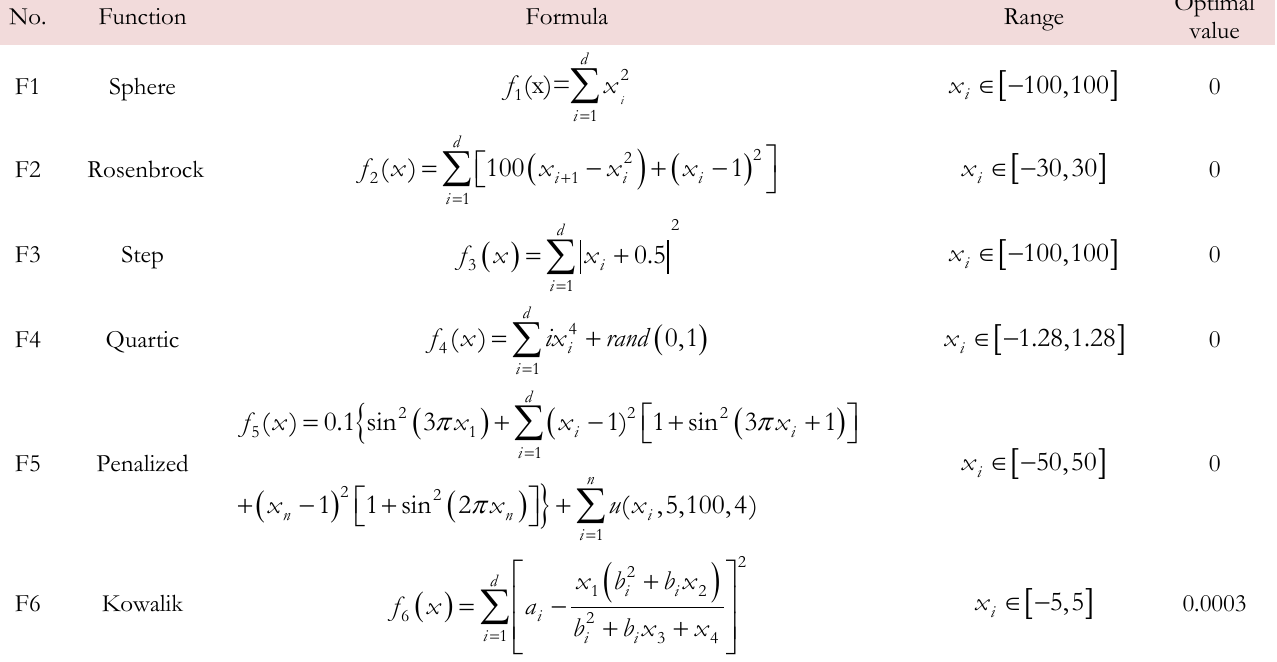
Table 1: Information of the benchmark